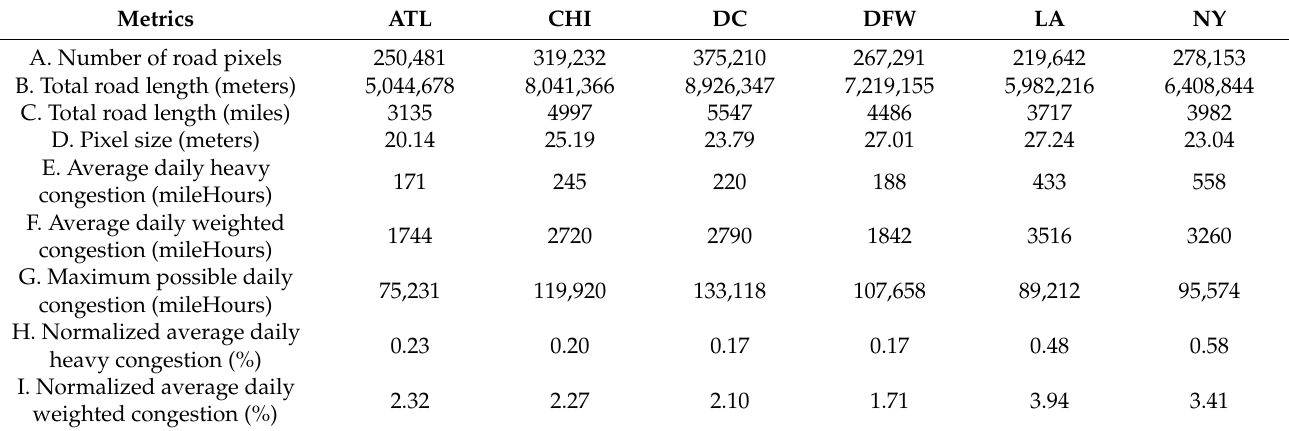
Table 1. Traffic congestion metrics of six U.S. metropolitan areas.